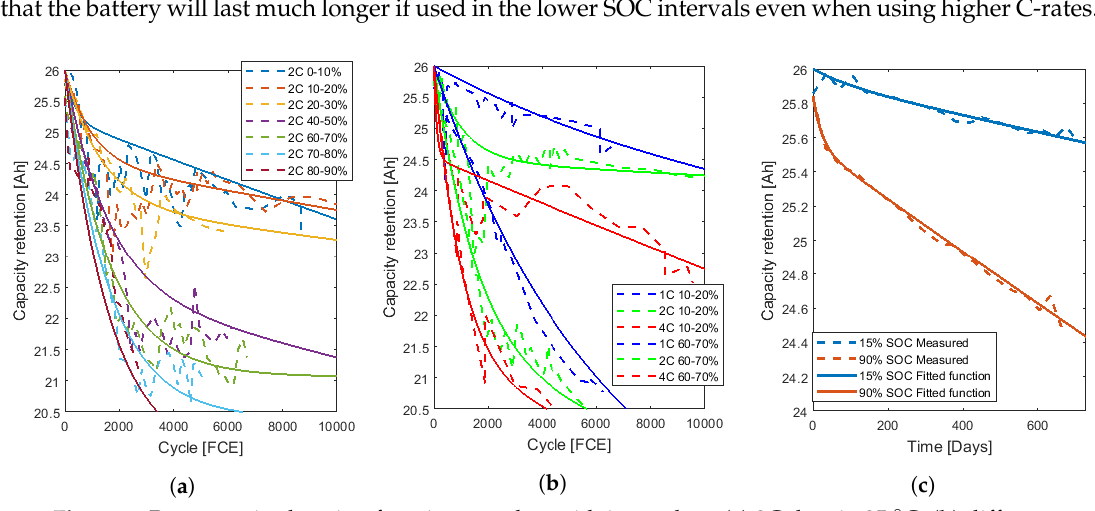
Figure 5. Parameterised ageing function together with input data, ( a ) 2C data in 25 ◦ C; ( b ) different C-rates in 35 ◦ C; and ( c ) calendar ageing in 25 ◦ C at 15% and 90% SOC and the corresponding degradation